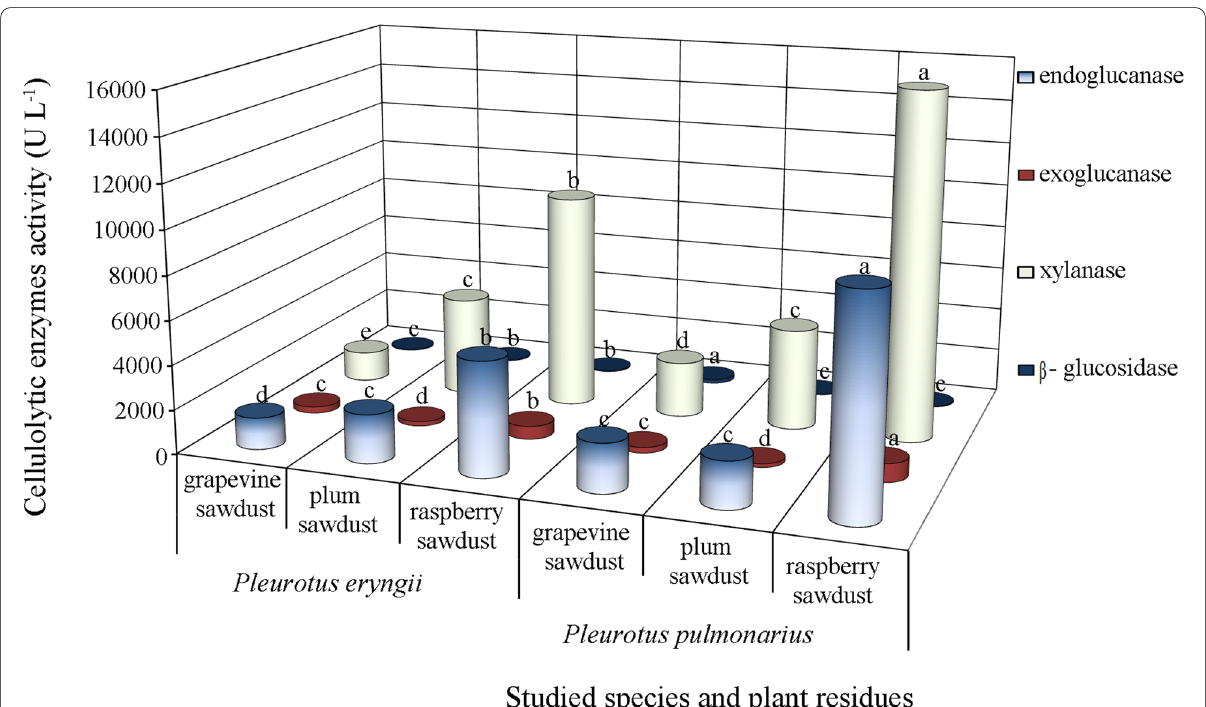
Fig. 2 Isoelectric focusing pattern of Pleurotus eryngii (1) and P . pulmonarius (2) laccases after the fermentation of pomiculture